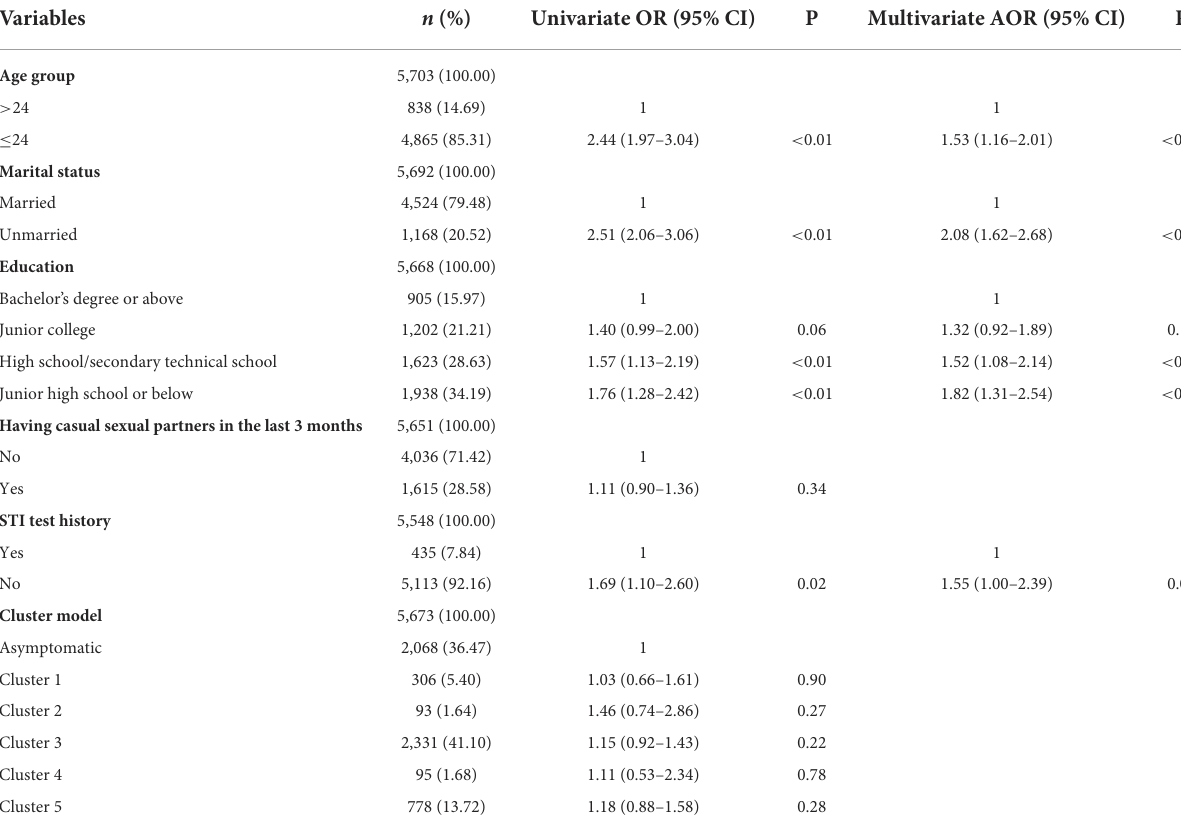
TABLE 6 Univariate and multivariate logistic regression analyses of factors associated with CT in women.